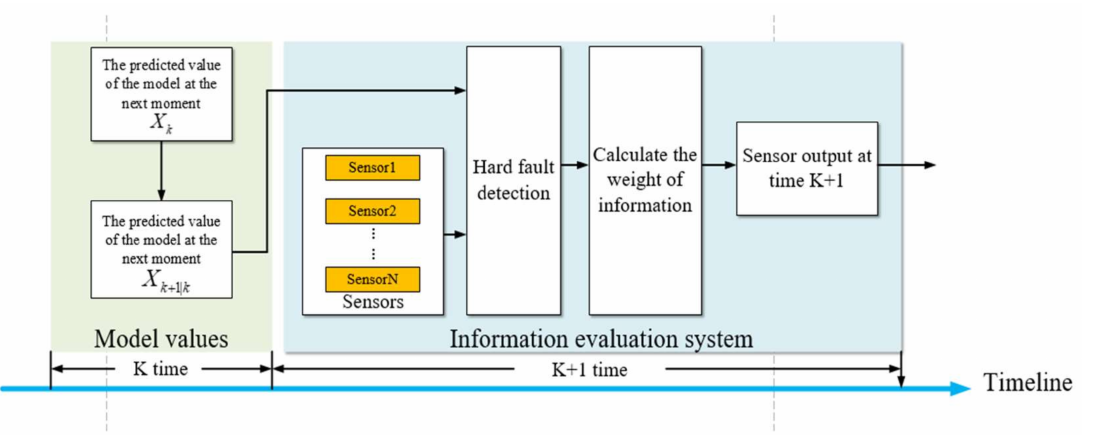
Figure 3. Diagram of information evaluation